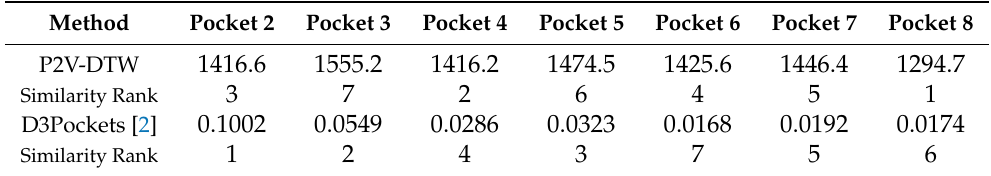
Table 3. Comparison of pocket similarity calculation methods.